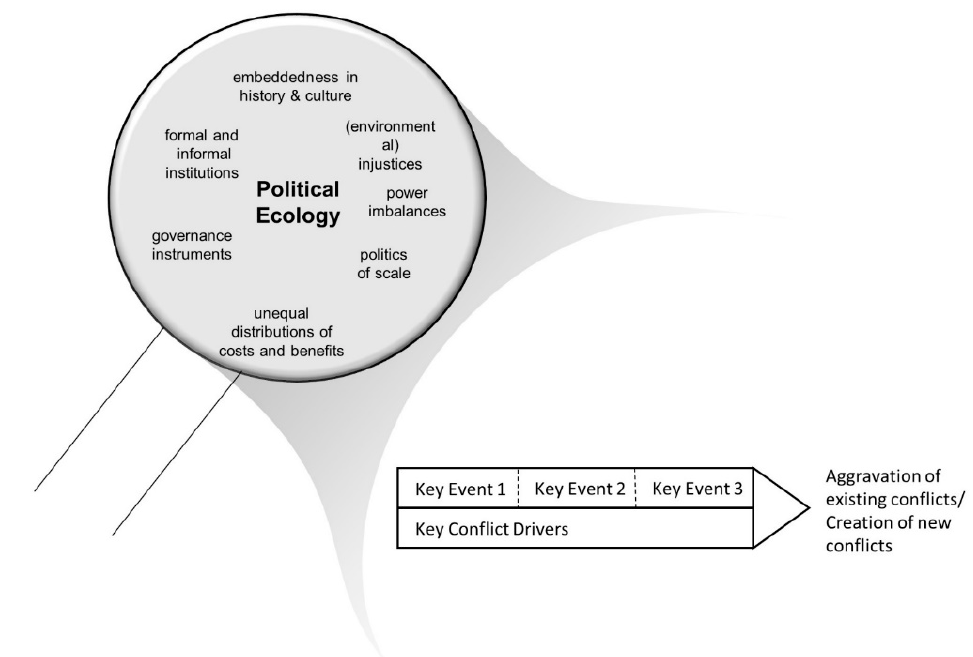
Figure 1. Conceptual framework [19] .